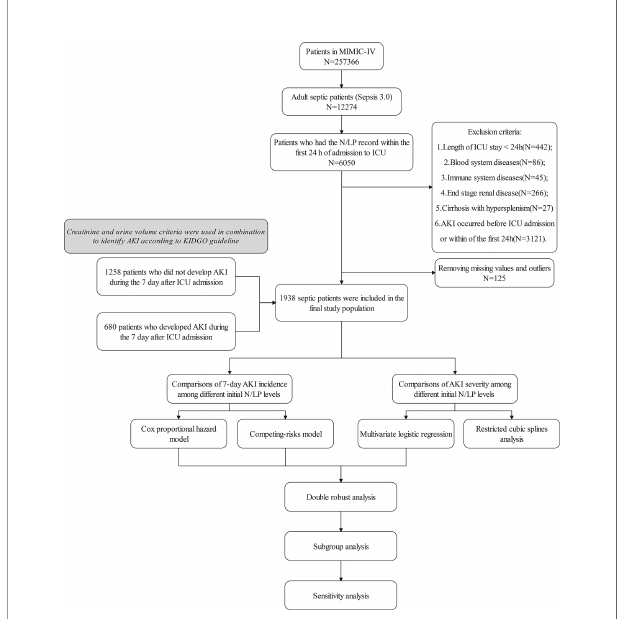
FIGURE 1 | Flowchart for analysis of the current